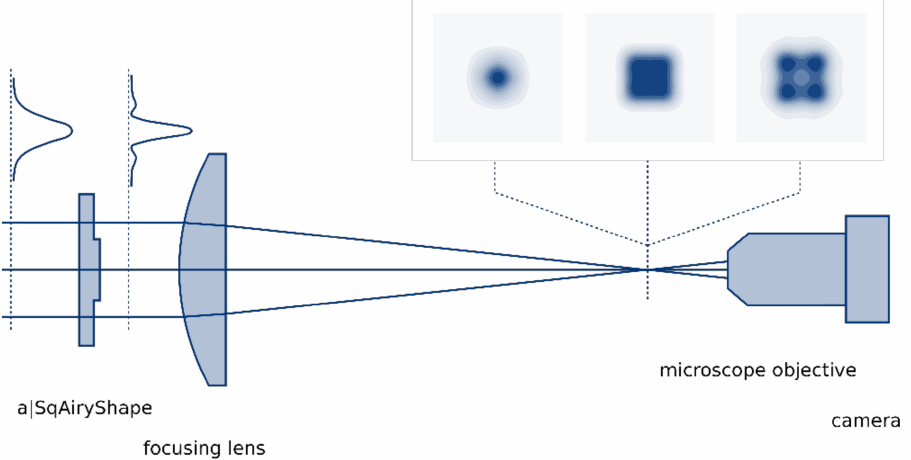
Figure 1. Experimental setup for characterization of the freeform beam-shaping